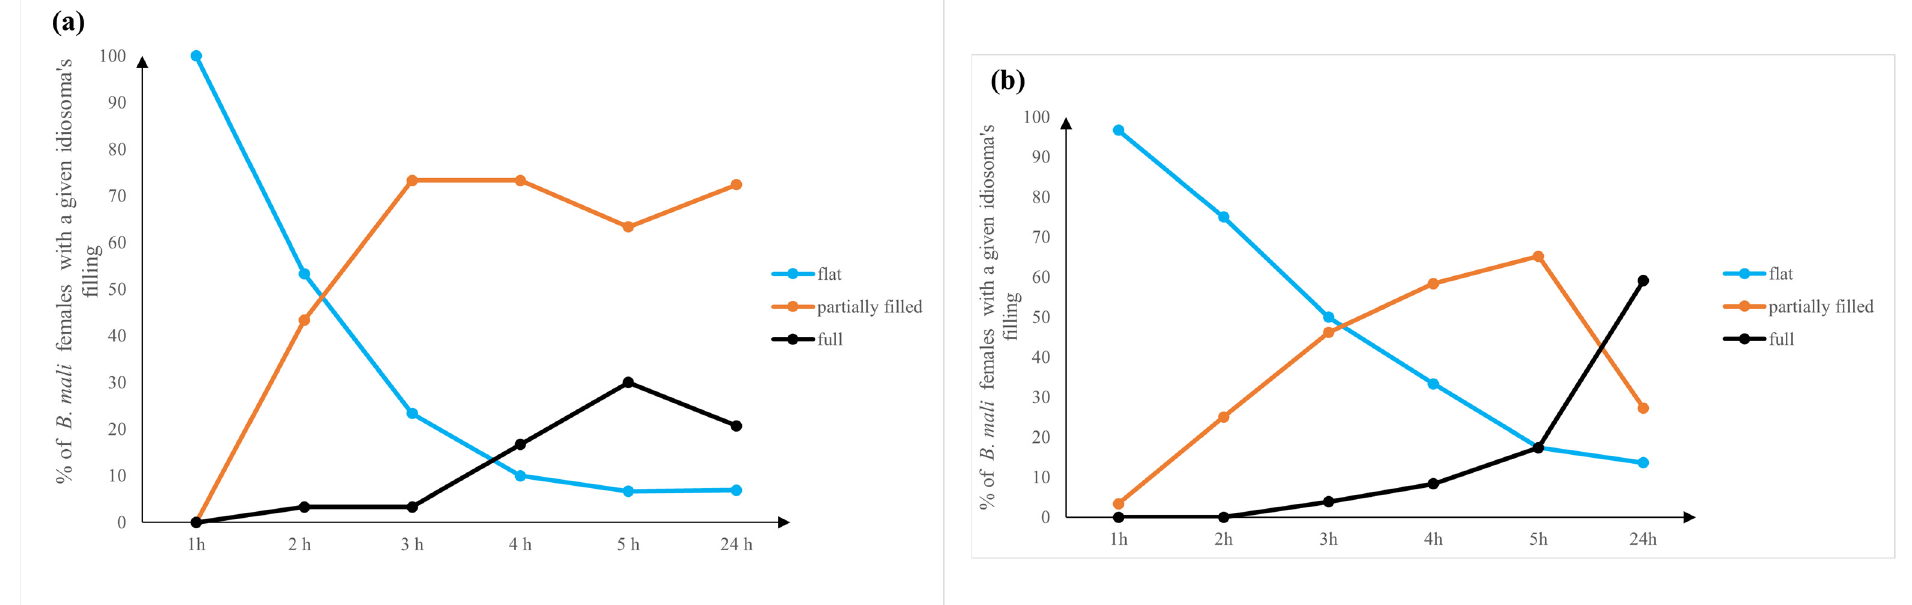
Figure 4. The degree of filling the idiosoma of Blattisocius mali females feeding on fruit flies of ( a ) Drosophila melanogaster and ( b ) D. hydei during 24 h